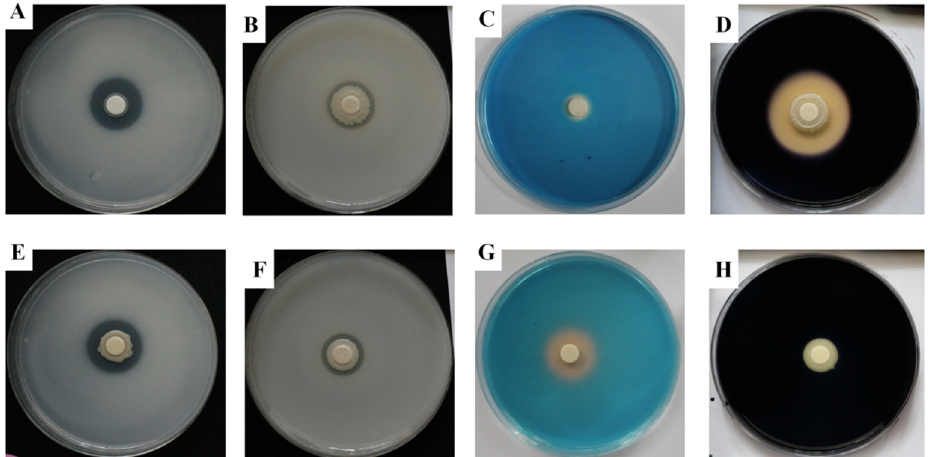
Figure 3. ( A , E ) In vitro phosphate solubilization on national botanical research institute’s phosphate growth (NBRIP) plates ( B , F ) zinc solubilization on Pikovskaya (PVK) agar plates supplemented with an insoluble ZnO (1.244 g/L) ( C , G ) siderophore production, and ( D , H ) amylase activity after seven days of incubation (top = strain KNU17BI2, bottom = strain KNU17BI3).